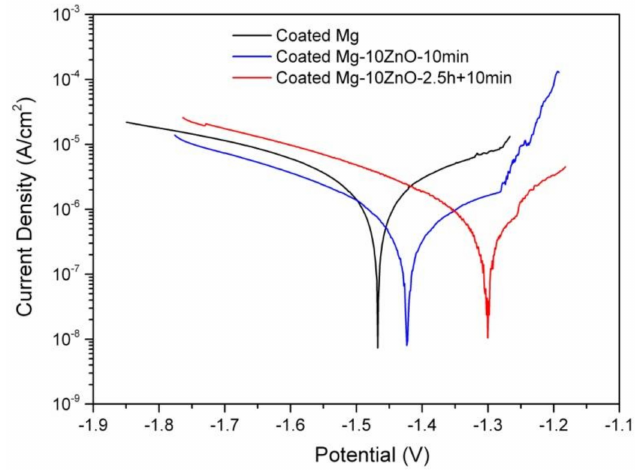
Figure 11. Potentiodynamic polarization curves of as-fabricated samples in Hanks’